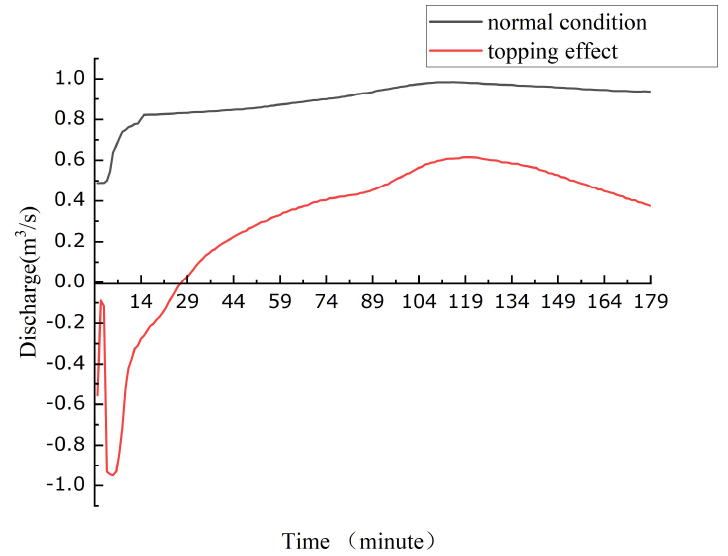
Figure 10. Comparison of discharge flow at the Daqing Road outfall before and after the water level rises under condition B. rises under condition B.